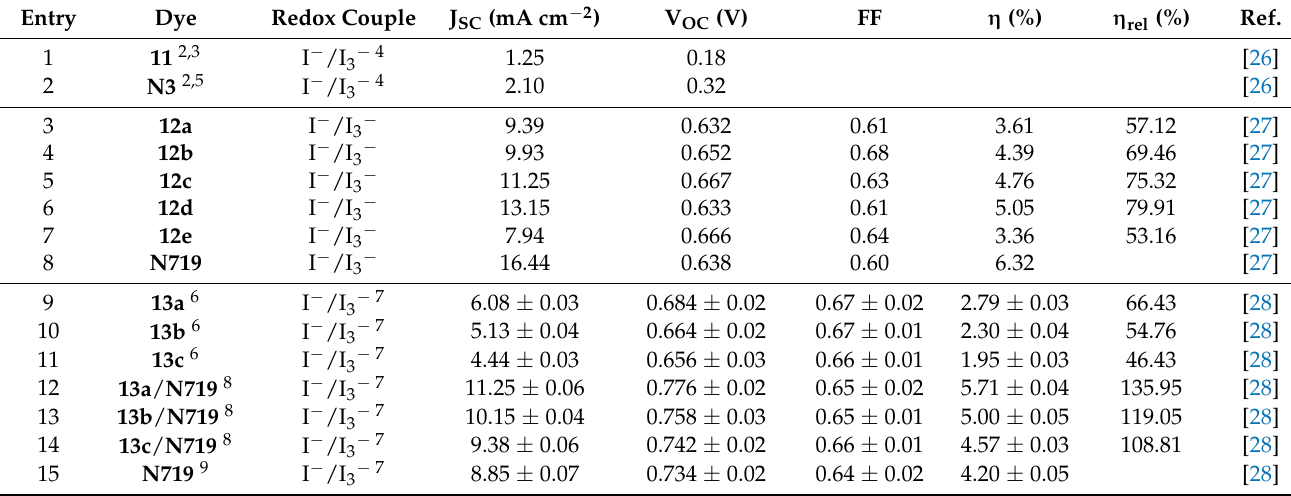
Table 3. Photovoltaic data of DSSCs produced with dyes 11 , 12a – e , and 13a – c 1